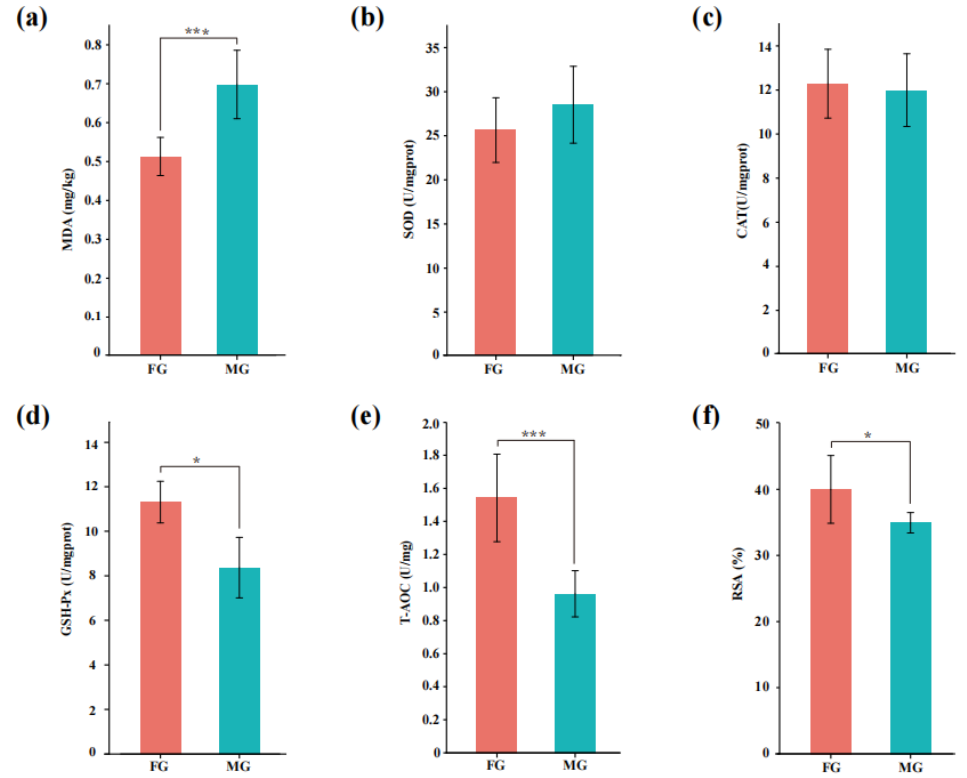
Figure 3. Antioxidant capacity of LT muscle of goats in two groups. ( a ) MDA content; ( b – d ) the activity of SOD, CAT, and GSH-Px; ( e ) the capacity of T-AOC; ( f ) the ability of radical scavenging. FG group, flatland-grazing group; MG group, mountain-grazing group; levels of significance: * sig- nificant at p < 0.05; *** significant at p < 0.001.